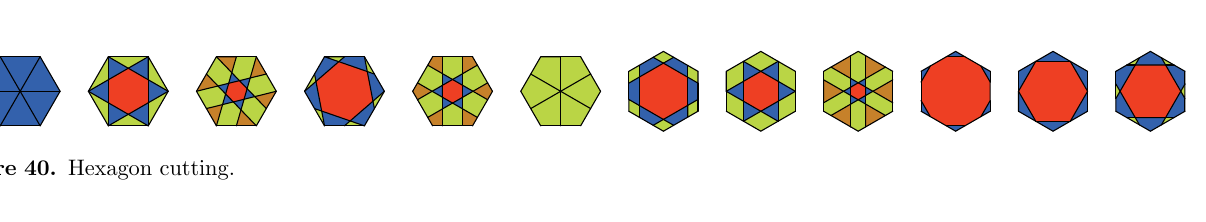
(cid:3) If the red square in Figure 39f is rotated by 45 (cid:3) the result is 39c. (cid:3) If the red square in Figure 39c is scaled to size zero, 39d results. (cid:3)